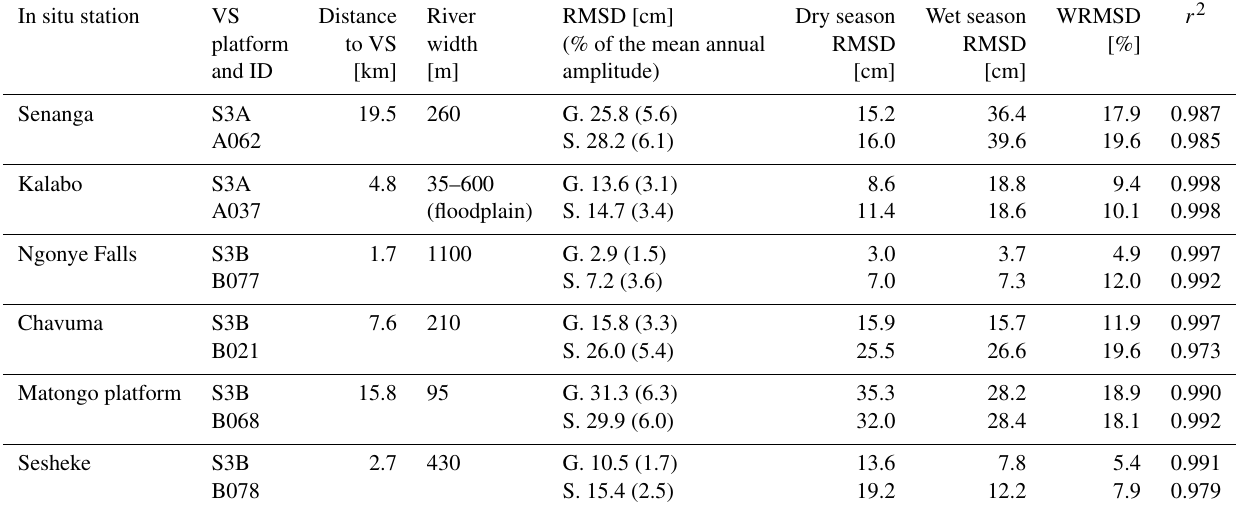
Table 5. Performance statistics compared to neighboring in situ gauge stations using the G. GPOD processing platform and S. SciHub to obtain satellite water surface elevation (WSE). The relative root-mean-square deviation (RMSD) is given in percent of the in situ